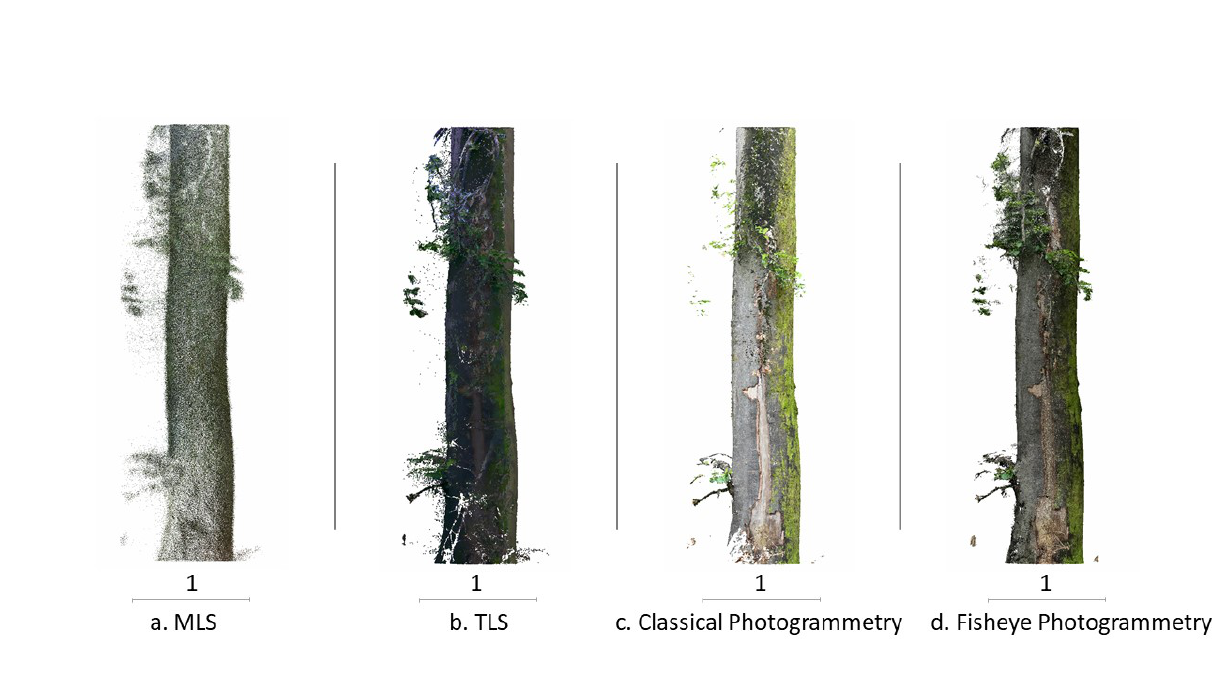
Figure 2. Transversal section of tree stem acquired by terrestrial remote sensing methods. Scale bar units are in meters.